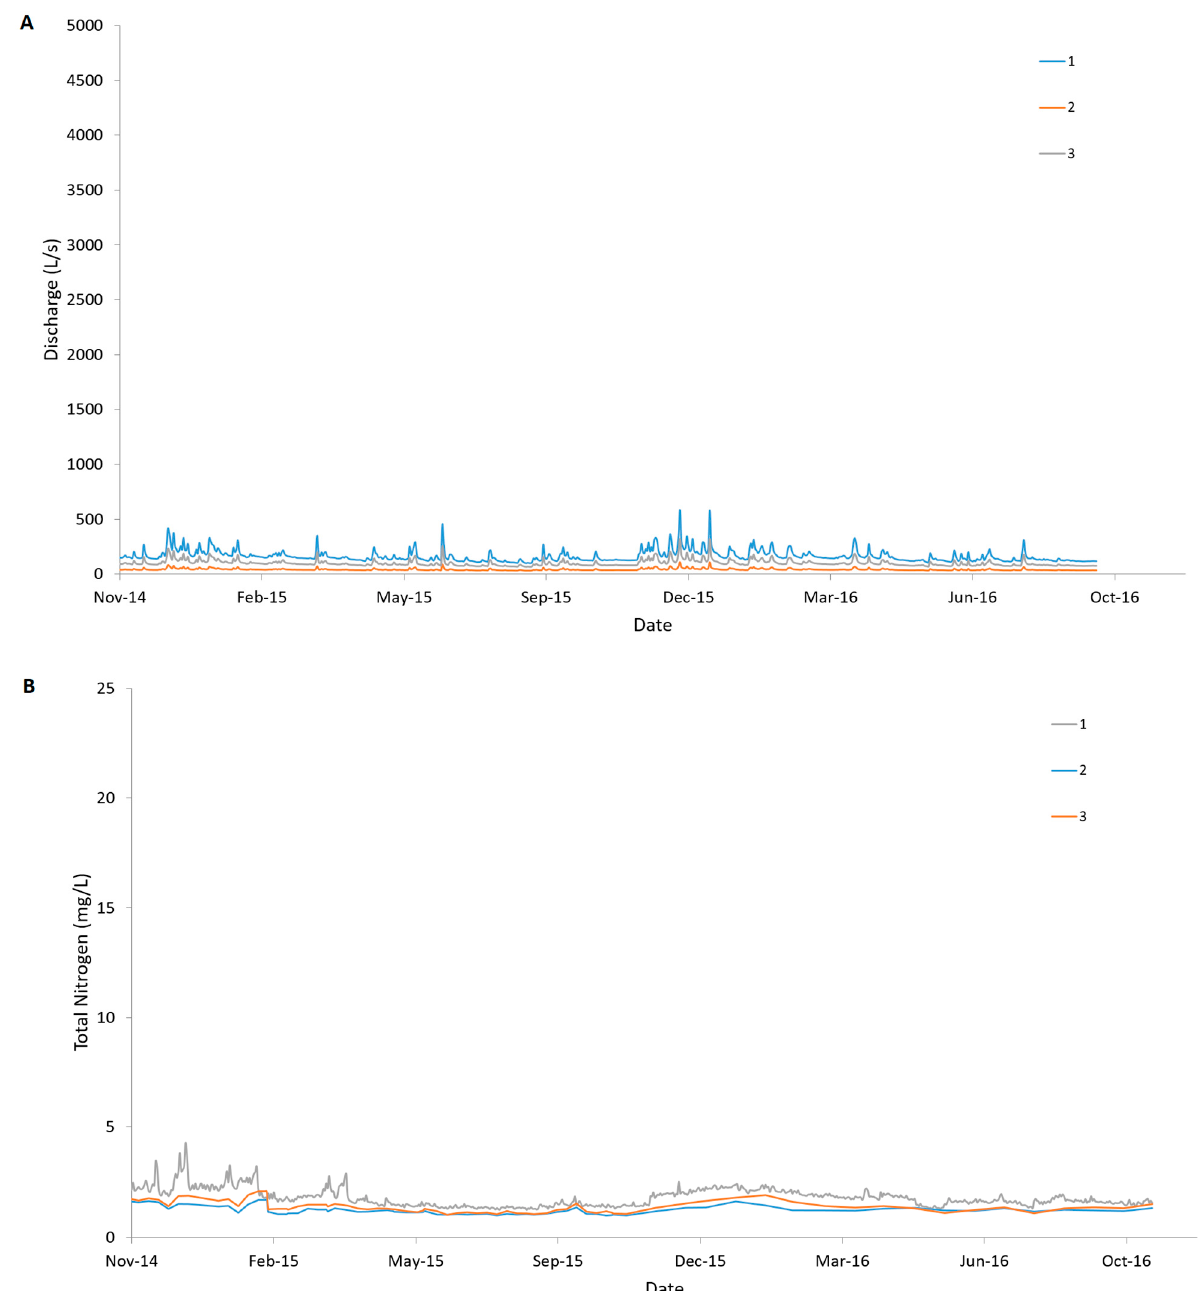
Figure A1. ( A ) Discharge measurement at the synchronous stations in the sub-catchment and at the main gauging station of the Jegstrup catchment in the period 2014 to 2016. ( B ) TN concentrations measured at the synchronous stations in the sub-catchment ant at the main gauging station of Jegstrup catchment in the period 2014 to 2016. Linear interpolation was used between weekly and fortnightly grab sample measurement to obtain daily measurements at the synchronous stations.